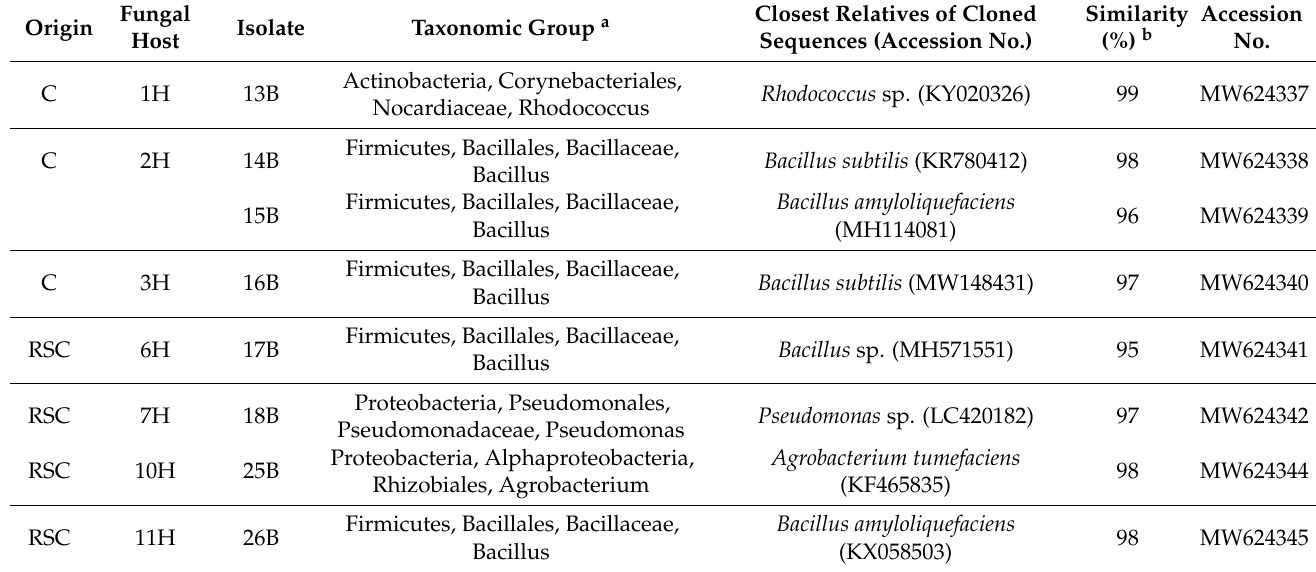
Table 4. Taxonomic assignment of bacterial isolates dispersing along of fungal hyphae (host) to the target agar in fungal highway column systems (FHCS). C and RSC refer to compost and rhizosphere soil with compost application,